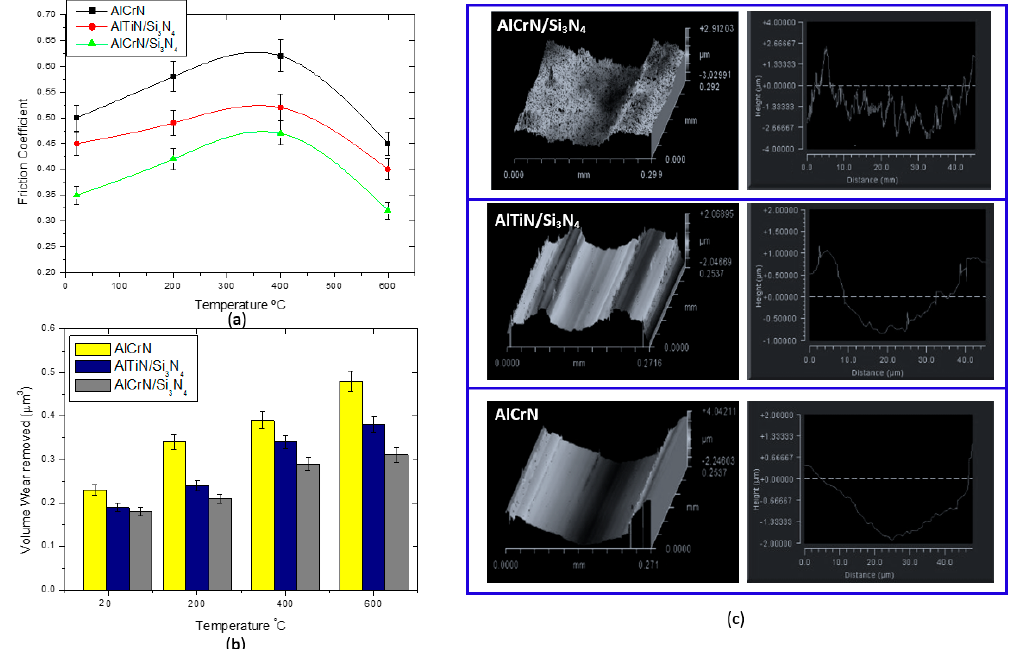
Figure 7. ( a ) Friction coefficient of the coatings at different temperatures; ( b ) Volume wear measured on the top of the surface after pin on disc test and ( c ) three-dimensional (3D) and two-dimensional (2D) profilometer images of the wear track profiles measured on the samples tested at high temperature (600 °C).